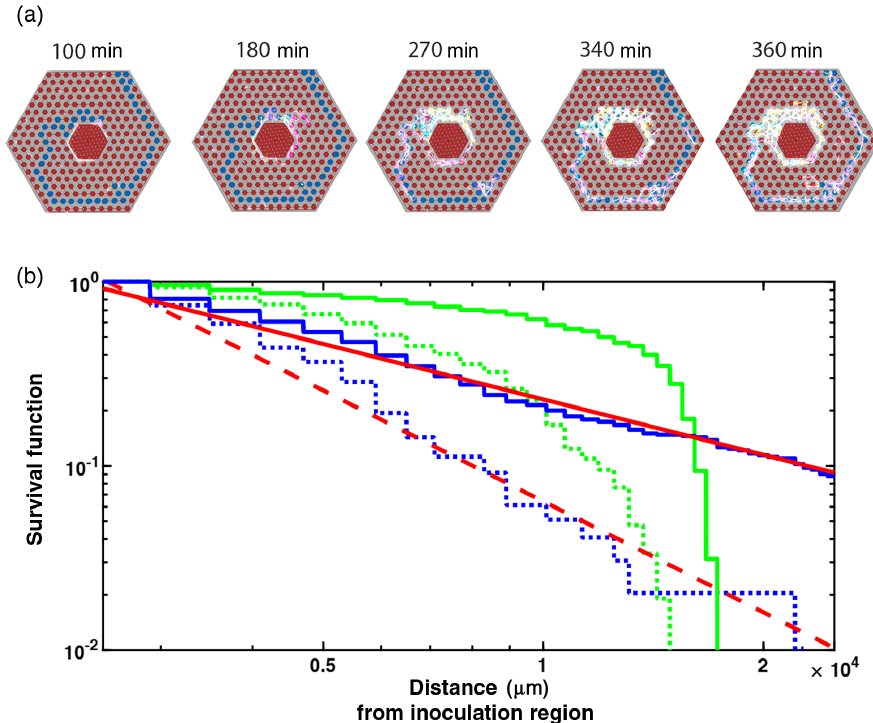
FIG. 2. (a) Stitched traces of chemotactic bacteria entering the maze with an outward flow from time of entry to the maze to exit of the maze. We have superposed the maze with red hexagons; the shortest path is shown with blue hexagons. (b) Survivor curves for bacteria. The solid green and blue lines are for nonchemotactic and chemotactic bacteria respectively at t ¼ 360 min from maze entry; the dashed green and blue lines are for nonchemotactic and chemotactic bacteria respectively at t ¼ 270 min from maze entry. The solid and dashed red straight lines are power-law fits to the survival function for chemotactic